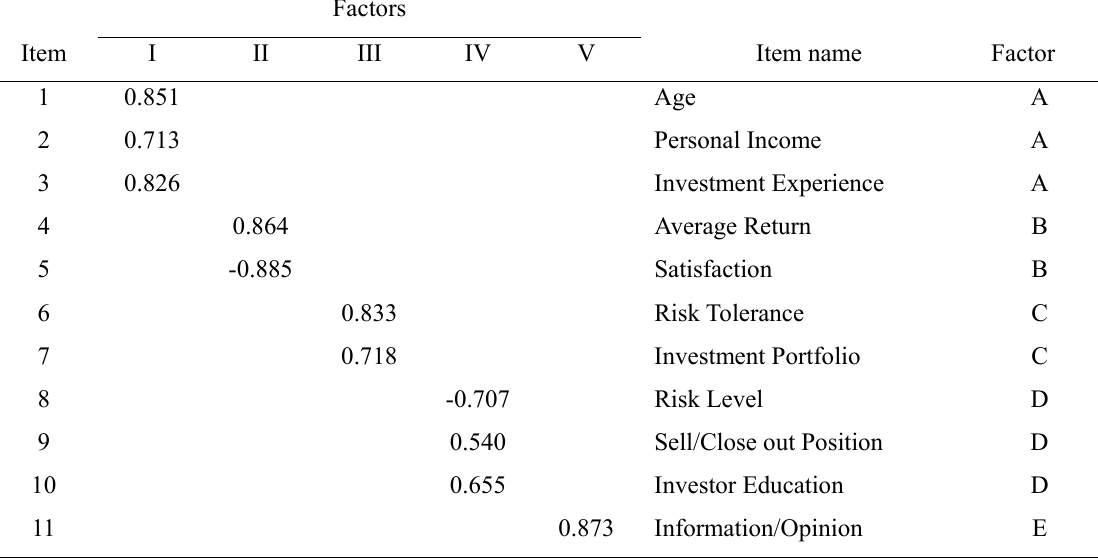
Table 5: Varimax-rotated principal component